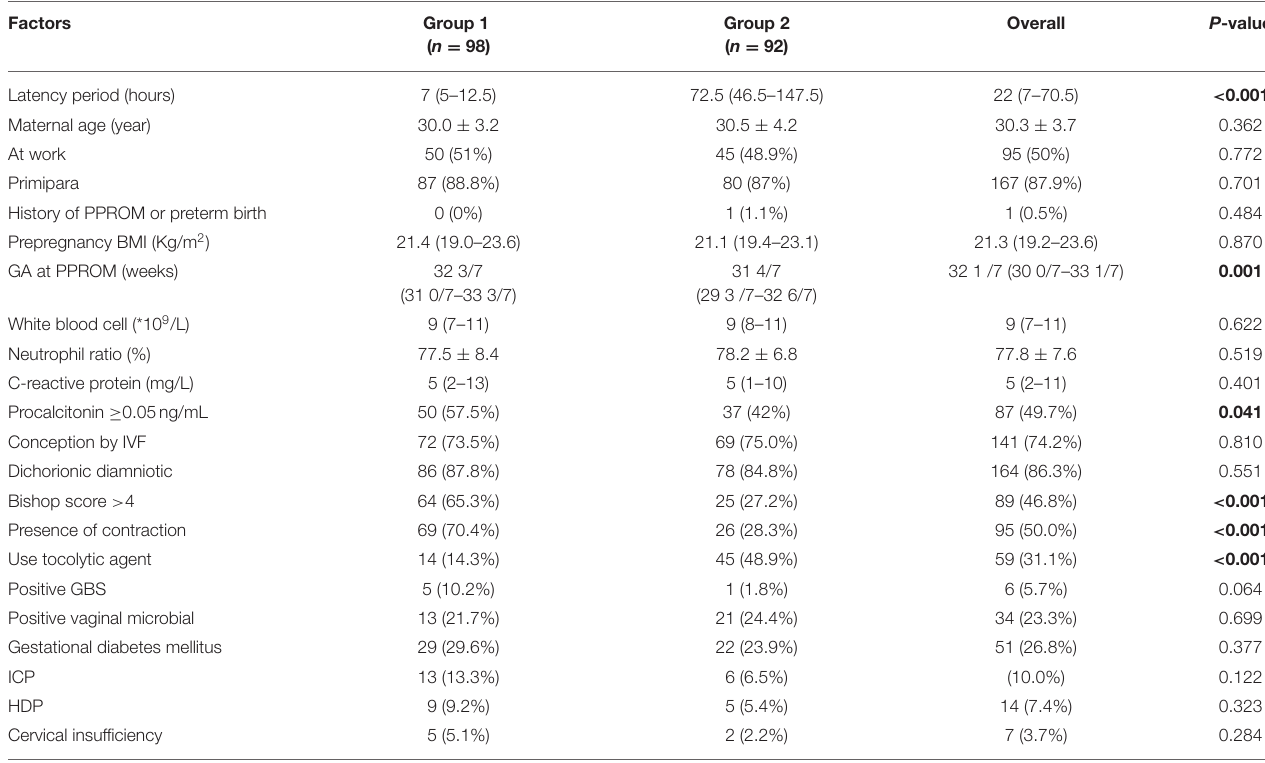
TABLE 1 | Comparison of clinical factors associated with short latency period.